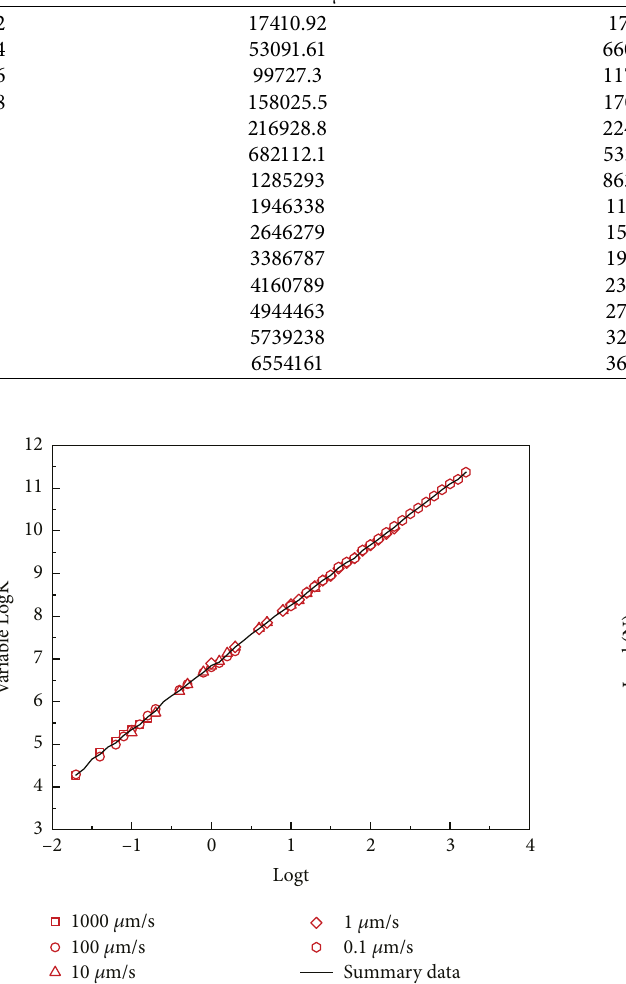
Figure 7: Data segment integration at different speeds.